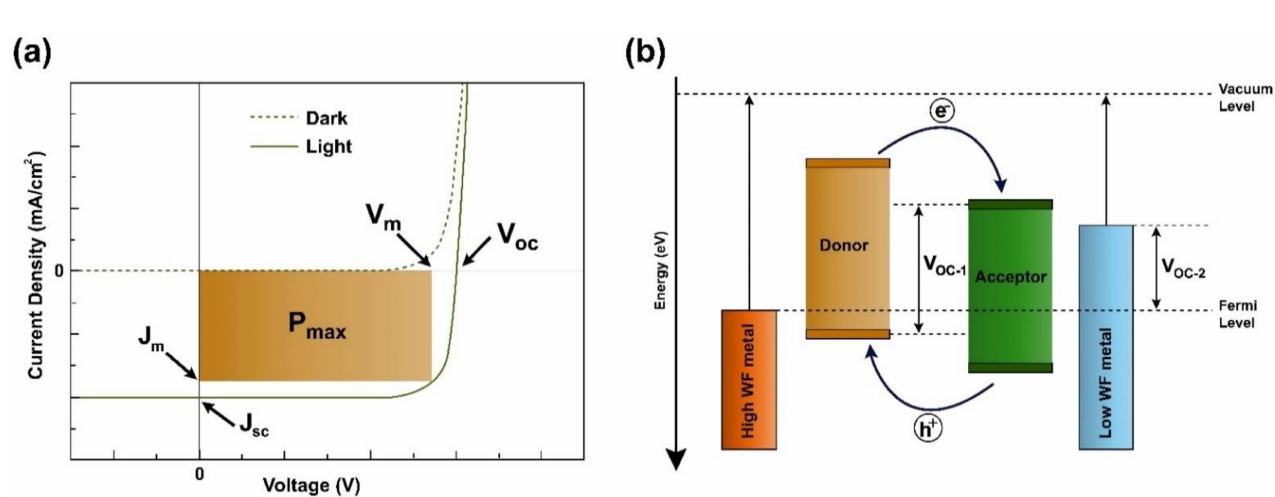
Figure 2. ( a ) Typical J-V curve and ( b ) schematic representation of the V OC in a conventional